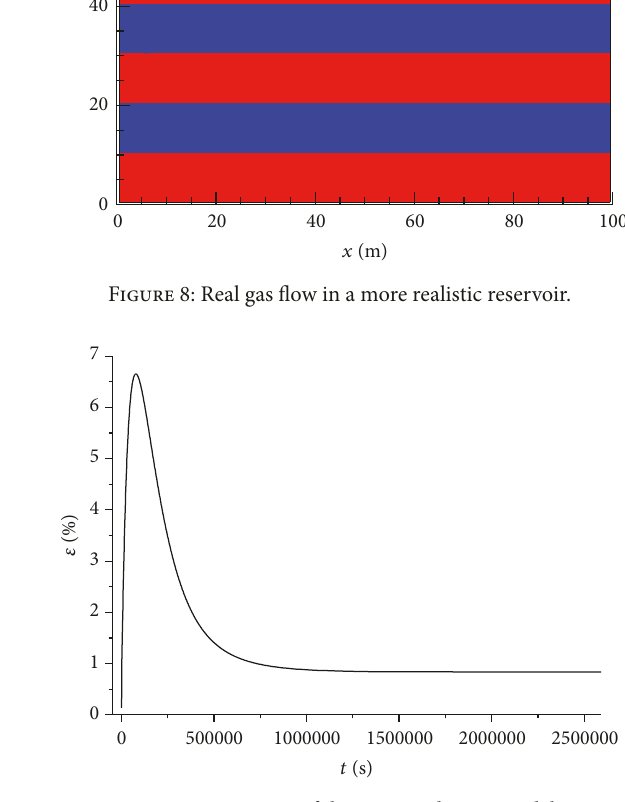
Figure 9: Precision of the improved POD